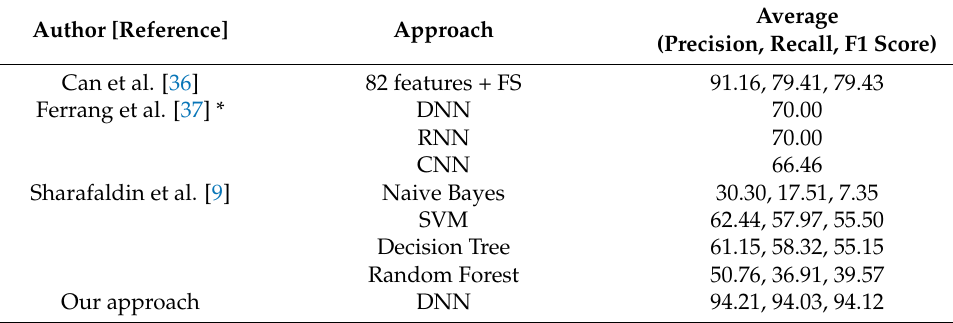
Table 9. Result comparison with related